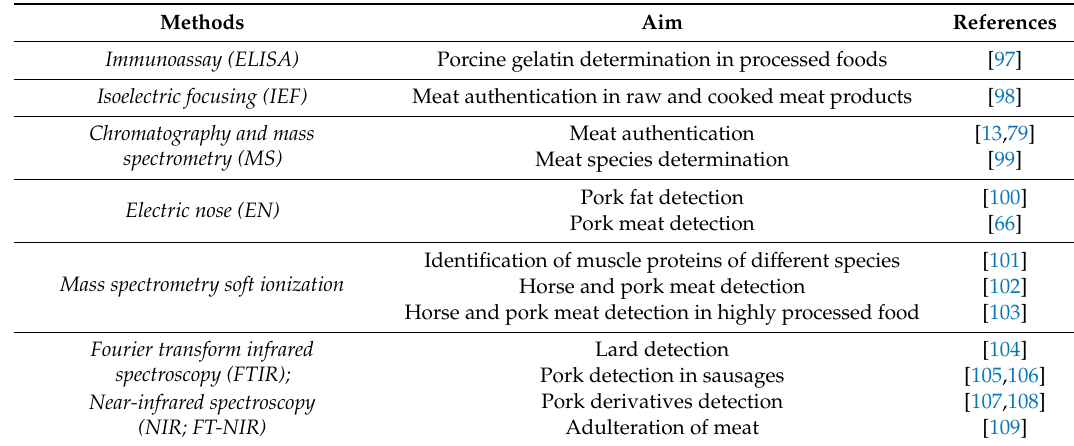
Table 2. Examples of protein-based methods for h.al¯al authenticity analysis.